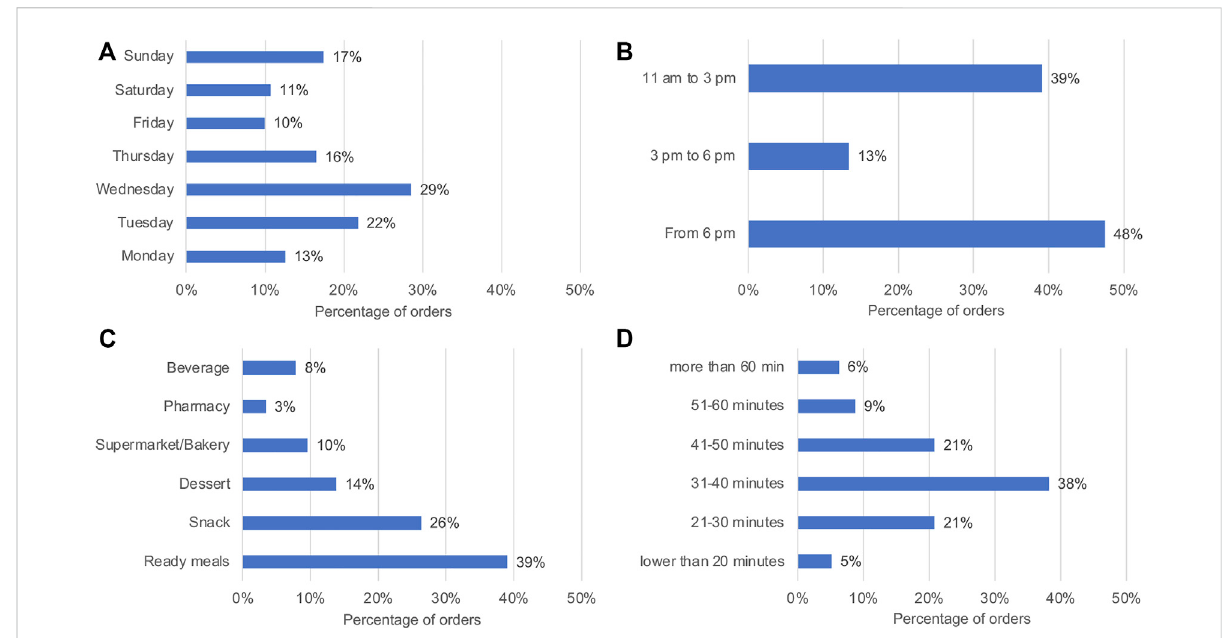
Data collection information: (A) week of the day of the order, (B) order time, (C) product type, (D) expected waiting